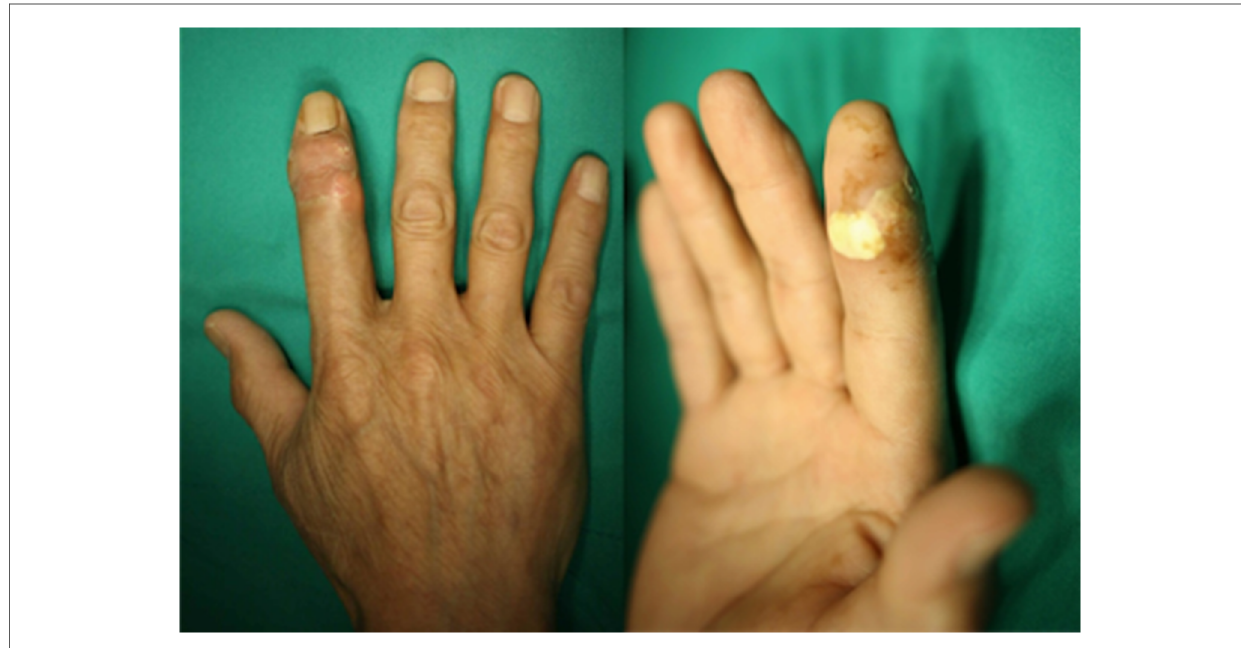
FIGURE 1 The right index fi nger with slight swelling and redness on the back of the right index distal interphalangeal joint, and obvious swelling and paleness on the palm side in the distal interphalangeal